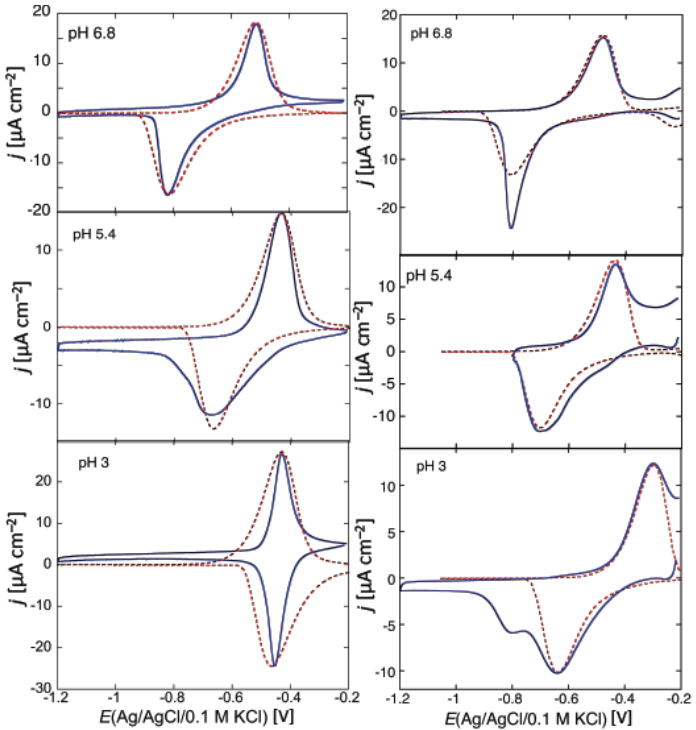
Figure 16. The solid blue curves are experimental cyclic voltammograms at a DPTL/DOPC tBLM in aqueous solutions of 0.1 M KCl at pH 6.8, 5.4 and 3, in the presence of either 0.1 μM gramicidin (left column) or 1 μg/mL SP25A (right column). Scan rate = 50 mV/s. The corresponding dashed curves were calculated as outlined in the text. (Reprinted from [66], Copyright 2015 and from [19], Copyright 2016, with permission from Elsevier).